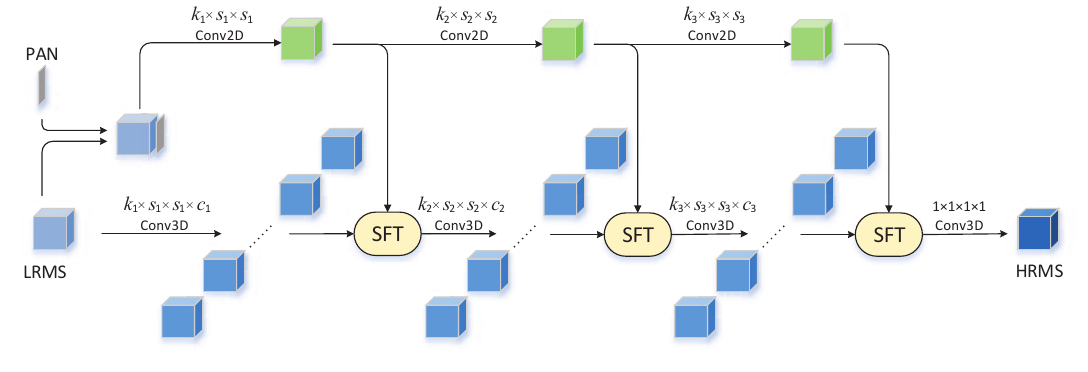
Figure 1. Overall structure of the spectral-aware pansharpening neural network (SA-PNN), which comprises a detail branch (green branch) and an approximation branch (blue